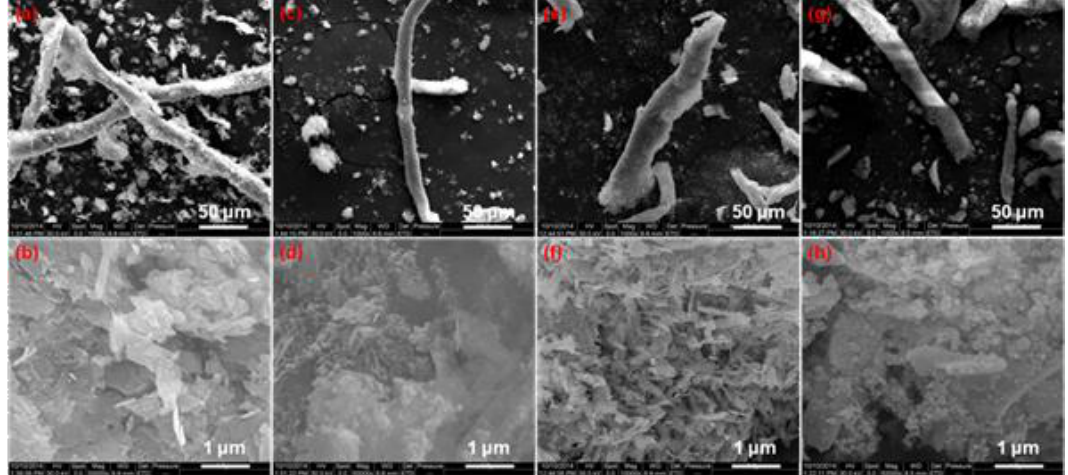
Figure 6. SEM images of different CuO-nitrocellulose (NC) and Al / CuO-NC composites. ( a , b ) CuO(b)-NC; ( c , d ) Al / CuO(b)-NC; ( e , f ) CuO(f)-NC; and, ( g , h ) Al /